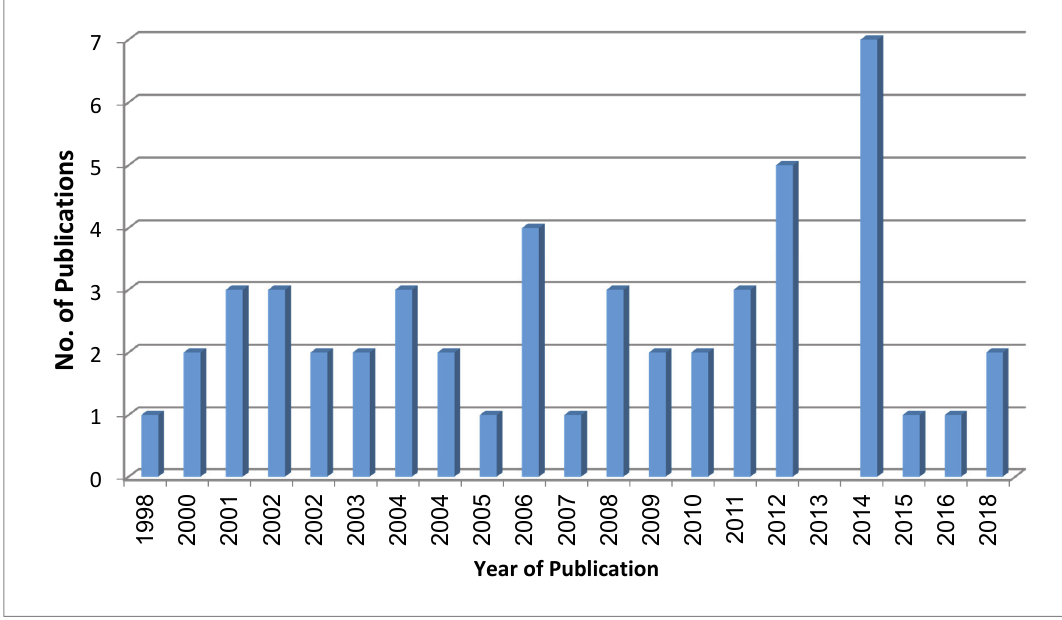
Fig. 2. The summary of articles used for the secondary